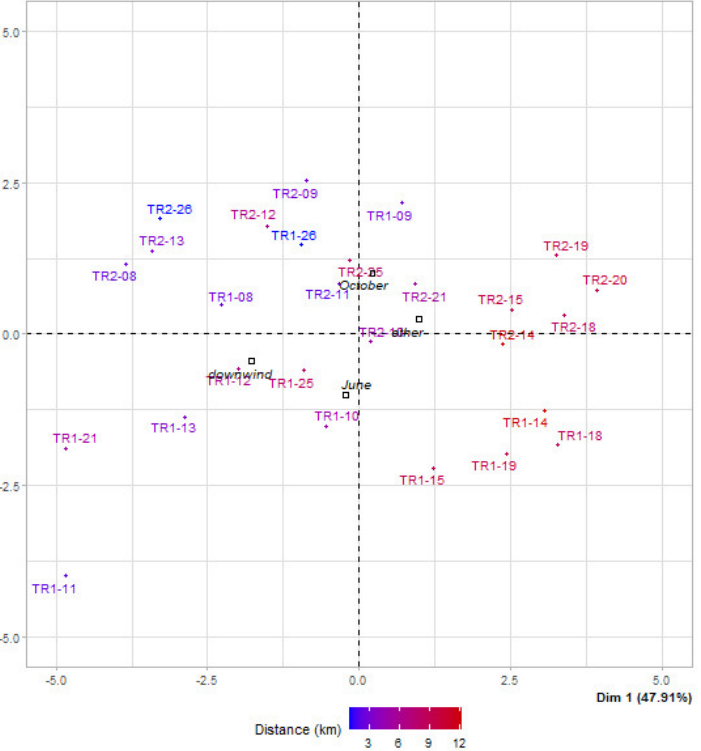
Figure 7. PCA results, first factor plane. Season, prevailing wind relative to the factory and distance from the factory are plotted as supplementary variables.